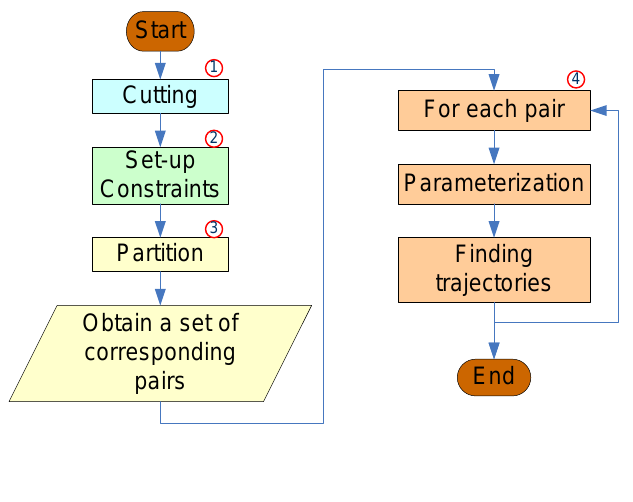
Figure 1. The block diagram of the algorithm.